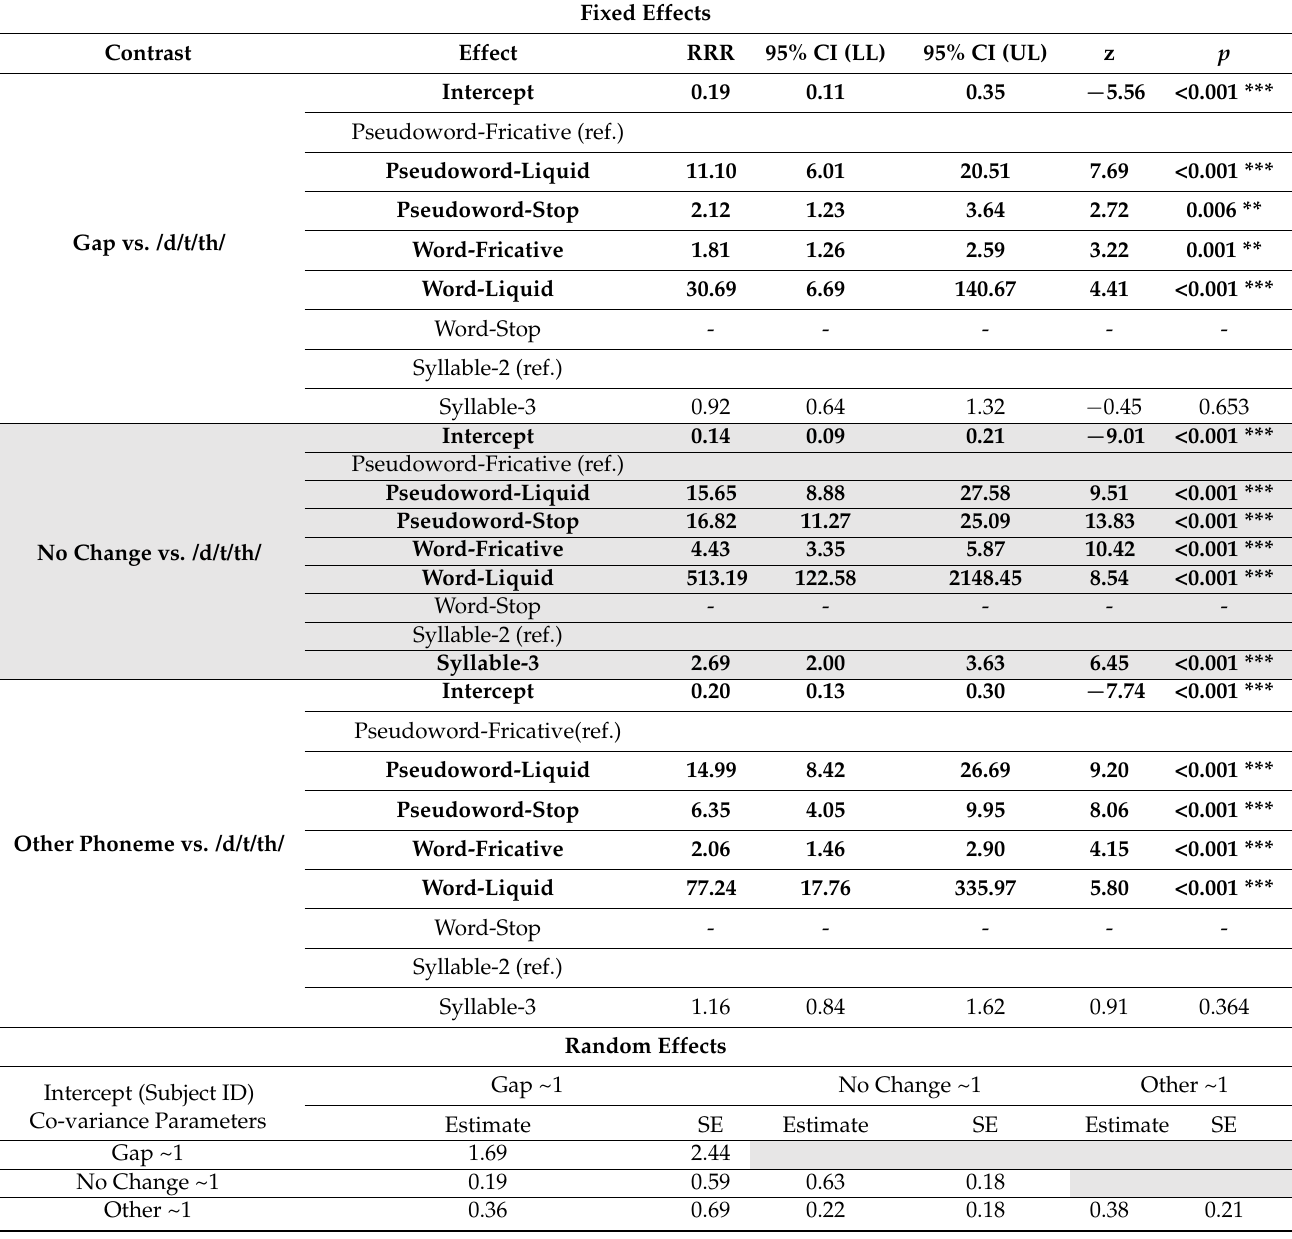
Table 3. Results of the follow-up mixed effects multinomial logistic regression, with Pseudoword- Fricative as the reference category for the Block Type-Manner of Articulation condition. Significant fixed effects/interactions are depicted in bold font and indicated with asterisks as follows: ** p < 0.01, *** p <